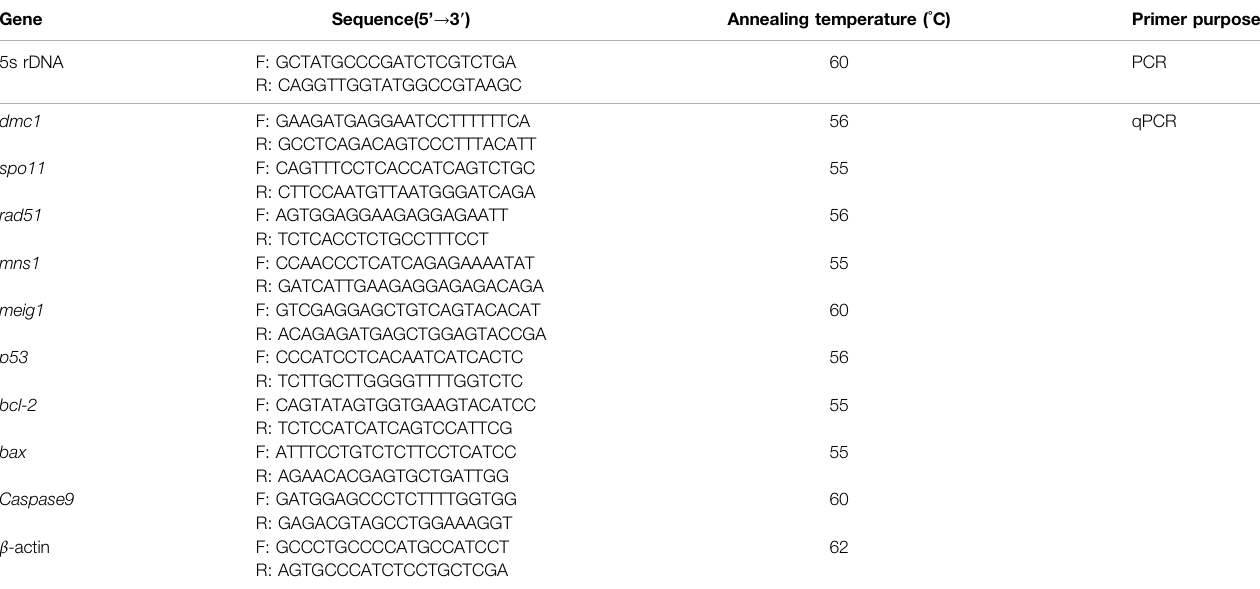
TABLE 1 | List of primers used in this study.